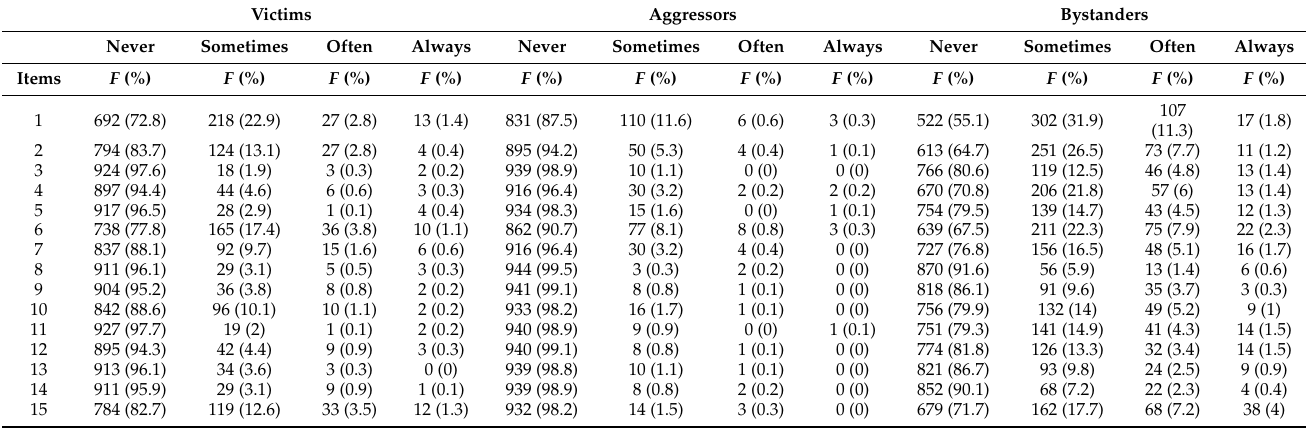
Table 1. Frequency (F) and percentage of participants suffering, perpetrating or witnessing cyberbullying behaviors in the last year. Victims Aggressors